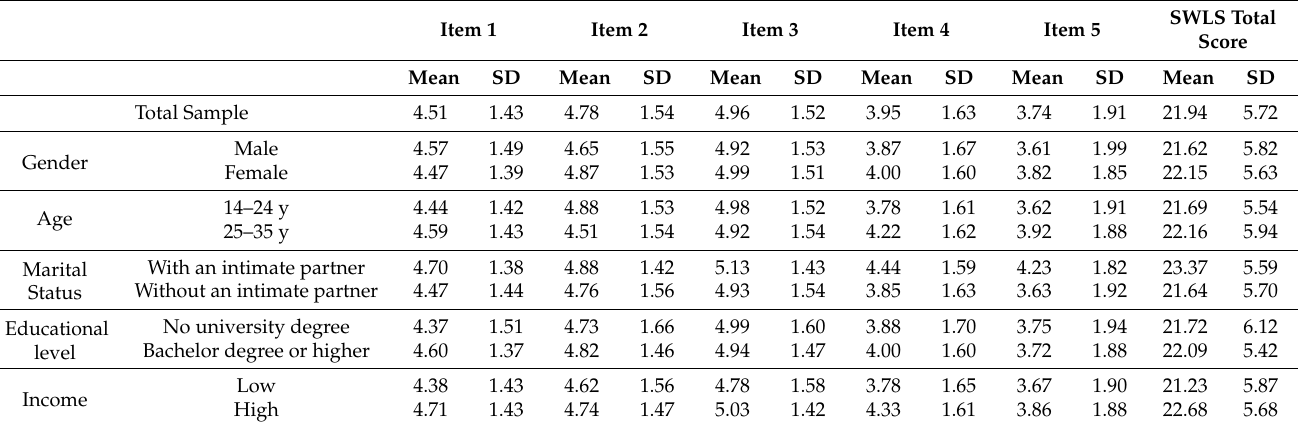
Table 2. Total score of the Satisfaction with Life Scale (SWLS) and items’ means and standard deviations for the total sample and for the dichotomized groups.